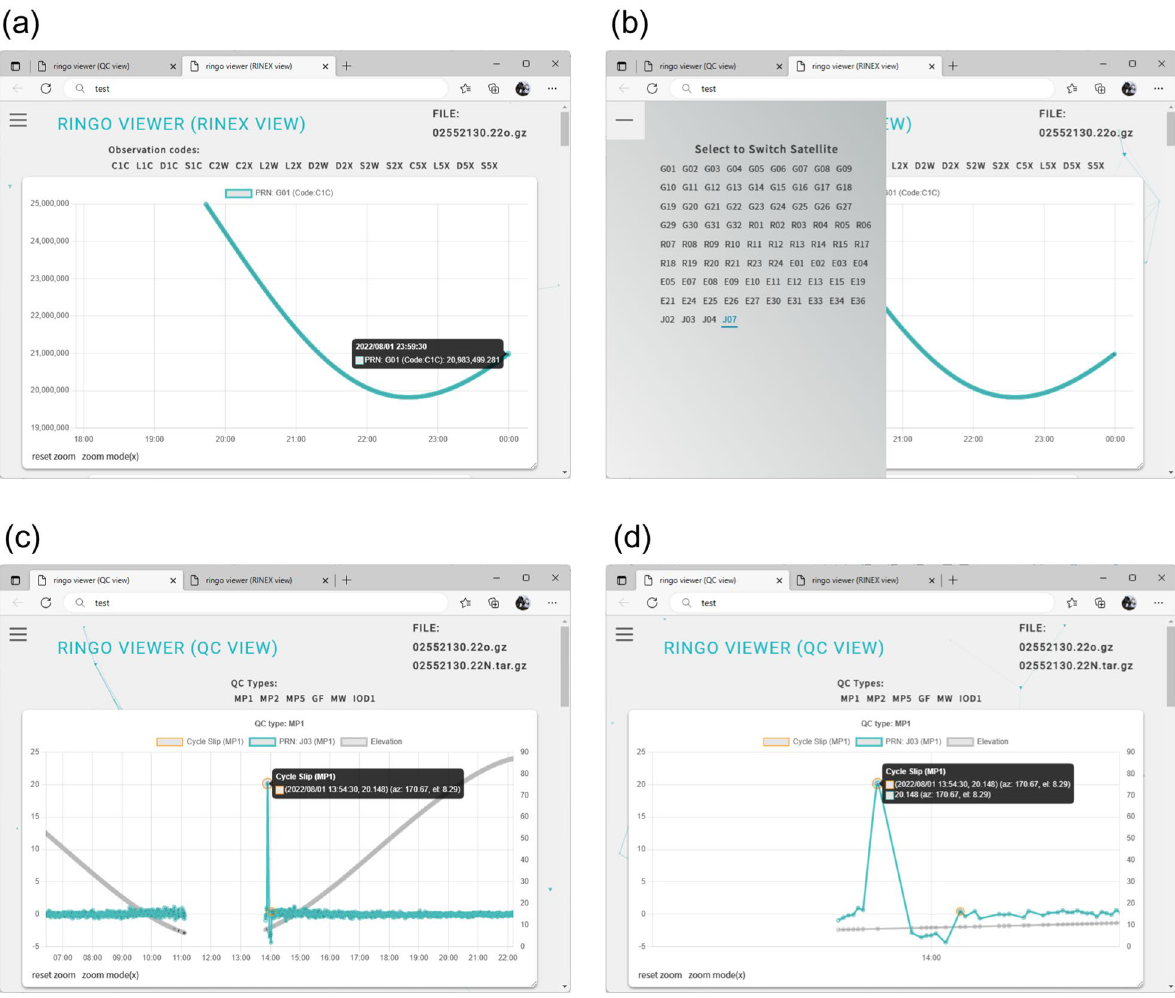
Fig. 6 Data visualization examples by RINGO “viewer” command. The appearances of a observation data display screen, b satellite switching screen, c quality check result display screen, and d enlarged view of the same panel. Each numerical value is also shown by tracing over the data points with the mouse